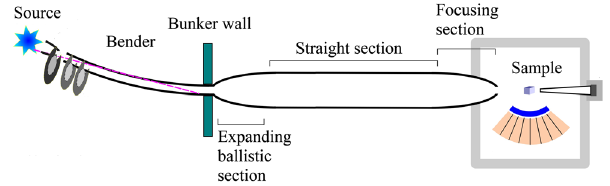
8. Rough outline of the BIFROST guide geometry. The figure is not to scale (from Ref.